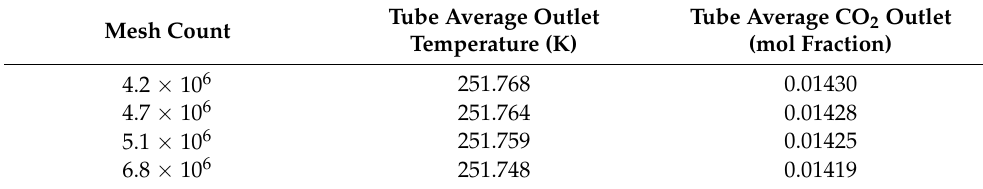
Figure 5. Mesh system for 1 m methanation module. ( a ) Front view of the reactor. ( b ) Longitudinal view. ( c ) Mesh system and sub domains detail. Table 4. Mesh independence test results.